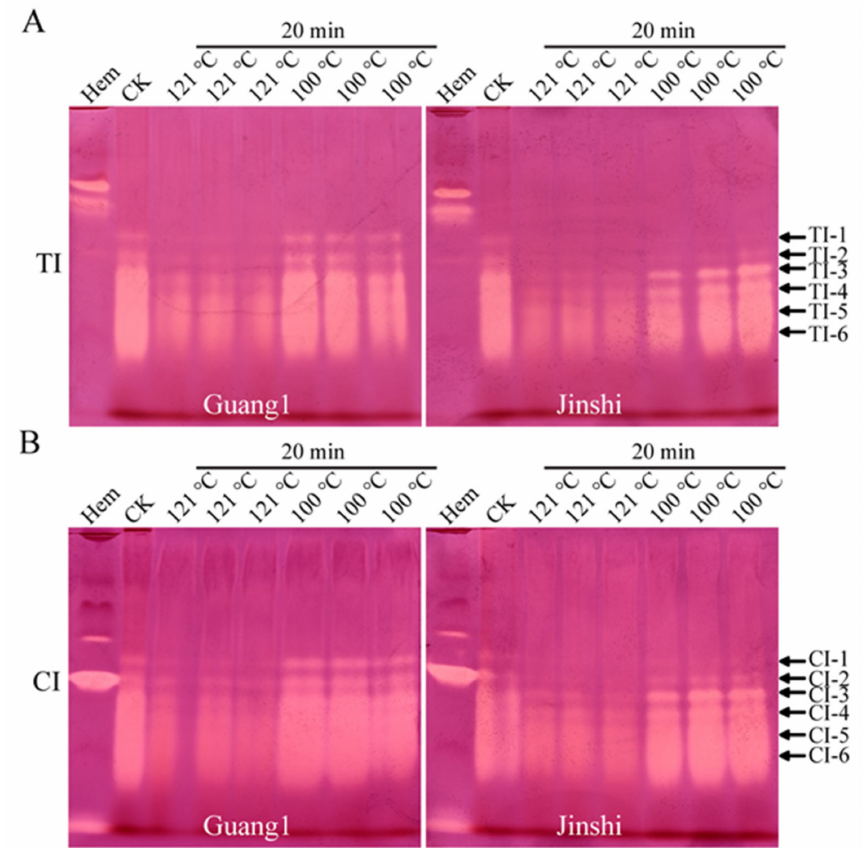
Figure 4. High temperature combined with high pressure could greatly weaken the activities of TIs and CIs from mulberry leaves. Activity staining of TIs ( A ) and CIs ( B ) from leaves of mulberry varieties Guang1 and Jinshi based on alkaline Native PAGE. “TI” and “CI” represent trypsin inhibitor and chymotrypsin inhibitor, respectively. B. mori hemolymph from day-5 fifth-instar larvae rep- resented by “Hem” was used as positive control. “121 ◦ C” and “100 ◦ C” show the mulberry-leaf proteins were incubated at 121 ◦ C or 100 ◦ C for 20 min. The arrows show activity-stained bands of trypsin inhibitors and chymotrypsin inhibitors, which are named “TI-1~TI-6” and “CI-1~CI-6” from top to